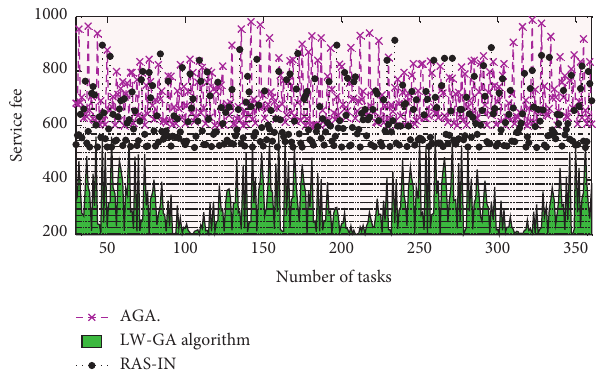
Figure 7: Comparison of service fees of the three